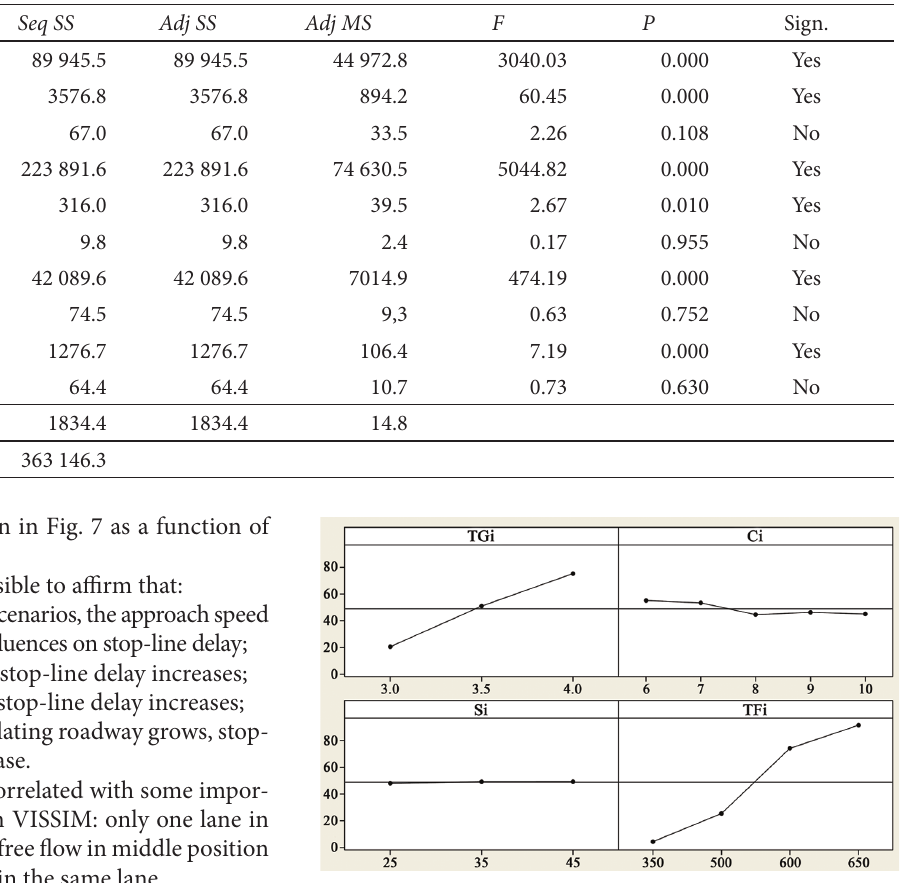
Fig. 7. Main plots for stop-line delays in C -scenarios